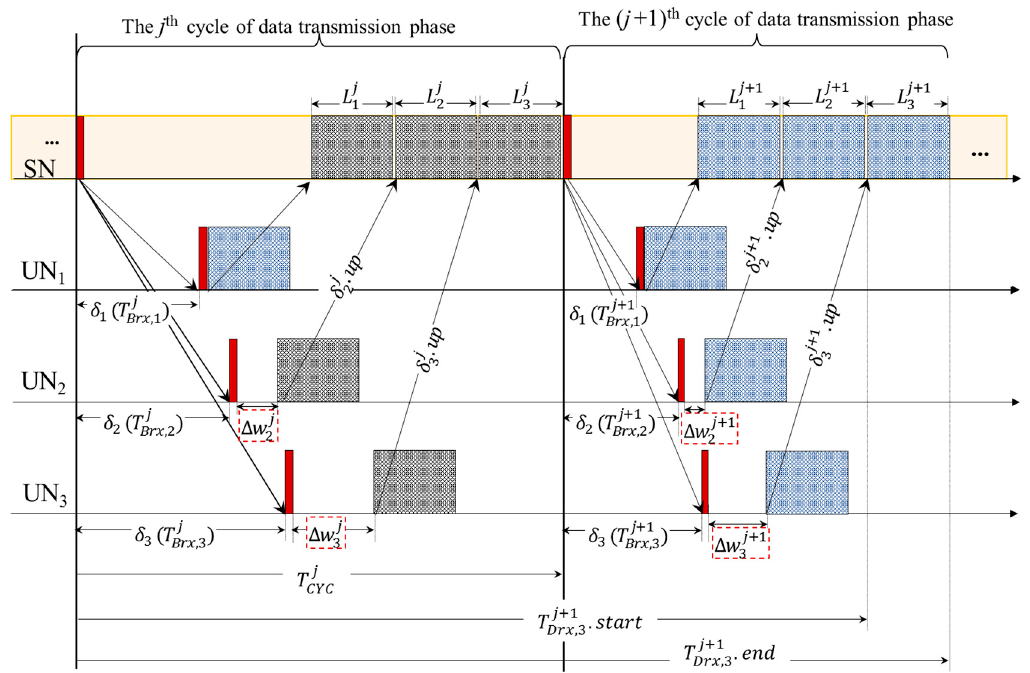
Figure 3. APD-TDMA with three UNs.